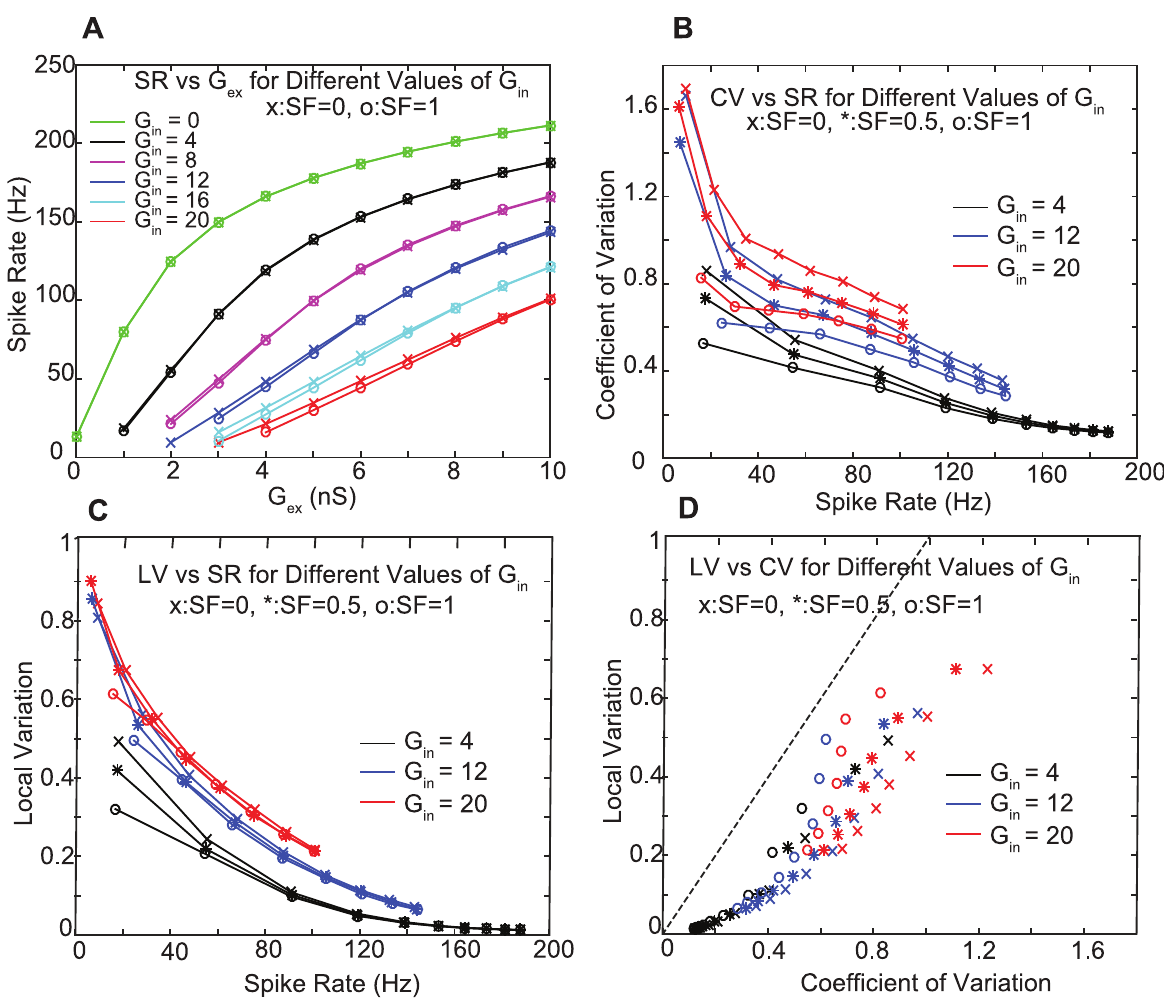
Fig 3. Model spike train statistics with PC and MF AST input matching recordings. A. Model spike rates for different gain factors in the unitary inhibitoryinput conductance (G in ) as a function of unitary excitatory input conductance (G ex ). There is little effect of 100% (SF = 0), and 0% (SF = 1) rate covariancebetweenPC inputs on spike rate (symbols are superposed in many cases). B. The model spike train CV as a function of spike rate (SR) for different values of G in and SF. Note that the CV for a given SR increaseswith increasing G in and with decreasingSF. C. The LV also decreases with SR and decreasing G in . It is much less dependenton SF than CV becauseit is not sensitive to slow rate changesthat result from rate covariancein the inputs. D. LV and CV are highly correlated,but the LV of model spikingis alwayslower than CV (dashedblack line denotes